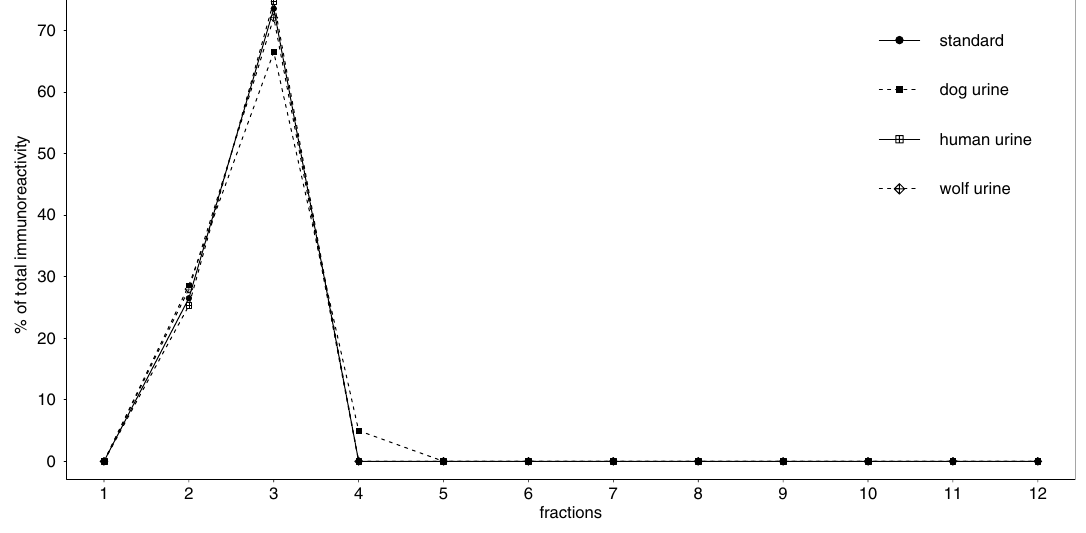
Figure 3. Percent of total immunoreactivity detected in each fraction in extracted oxytocin (OT) standard and extracted dog, wolf, and human urine.